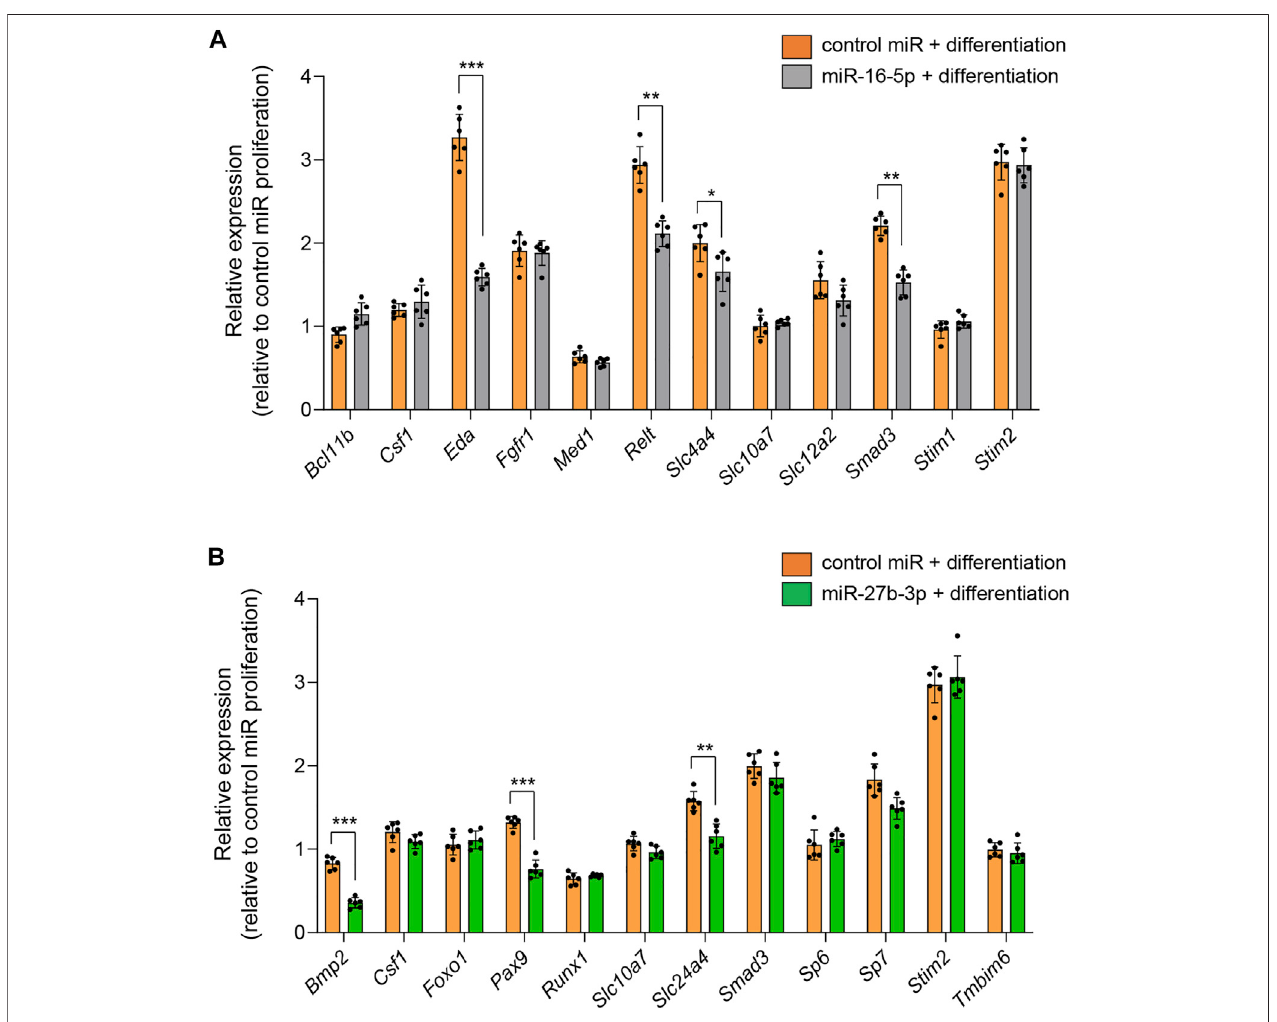
FIGURE 5 | Effects of overexpression of miR-16-5p and miR-27b-3p on expression of target genes. (A) Quantitative RT-PCR analyses for target genes after treatment with control and miR-16-5p mimic under differentiation conditions ( n = 6). * p < 0.05; ** p < 0.01; *** p < 0.001. (B) Quantitative RT-PCR analyses for target genes after treatment with control and miR-27b-3p mimic under differentiation conditions ( n = 6). ** p < 0.01; *** p <